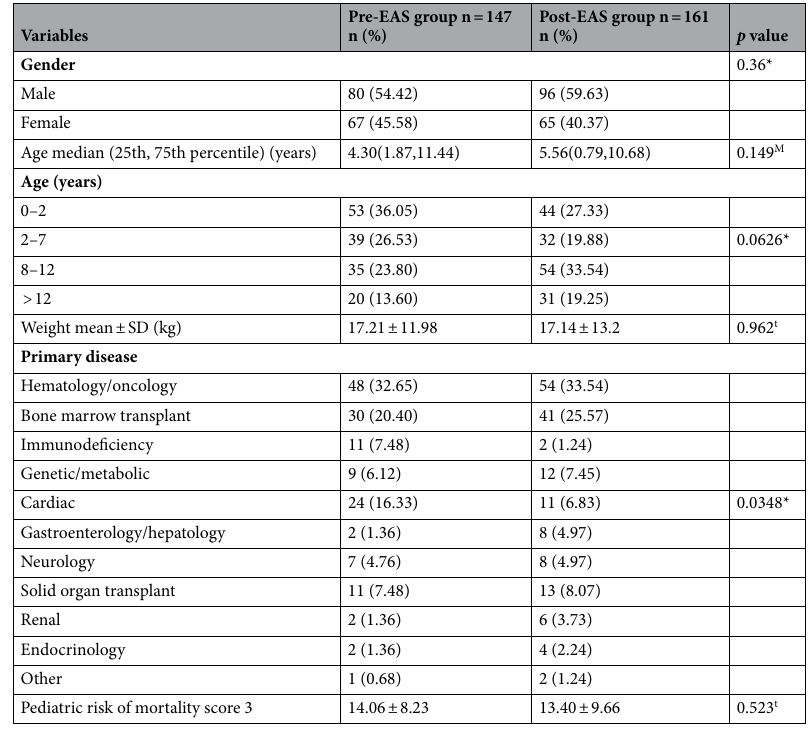
Table 1. Baseline demographic and clinical characteristics for the pre- and post-EAS groups. EAS electronic alert system, SD standard deviation. The p -value was calculated using the indicated statistics: t Student’s t -test, *chi-squared test, M Mann–Whitney U